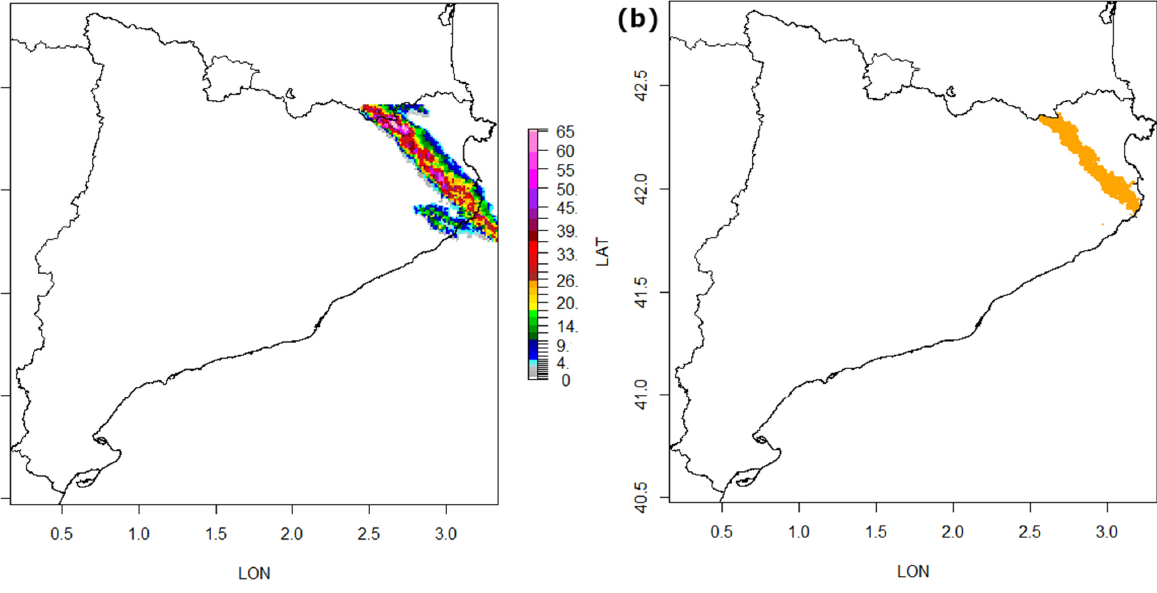
Figure 2. ( a ) Daily maximum VIL field for the 30 August 2022 (the hail event with the largest hail size recorded in Catalonia, with more than 10 cm diameter). ( b ) The orange area is the result of applying crop and thresholding techniques to the previous field, indicating the area hit by hail larger than or equal to 2 cm in Catalonia.